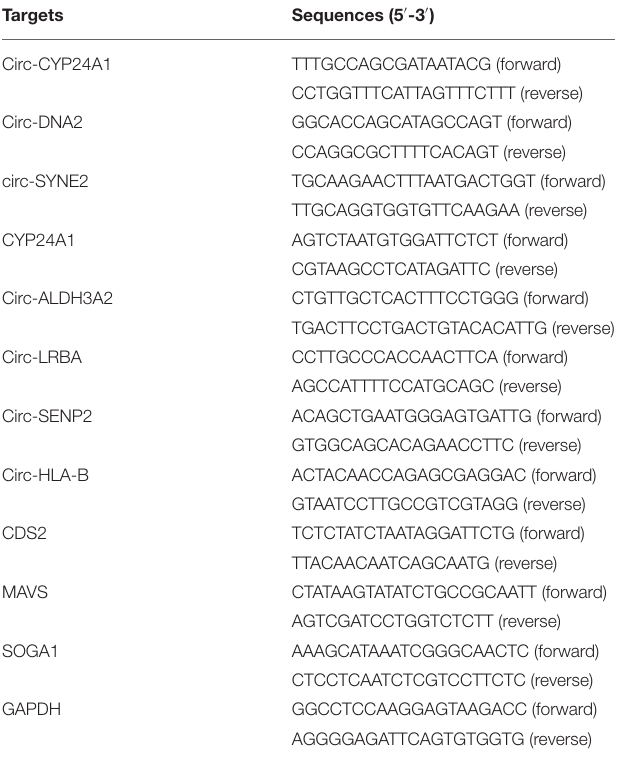
TABLE 1 | The primer sequences of RT-qPCR. Targets Sequences (5 ′ -3 ′